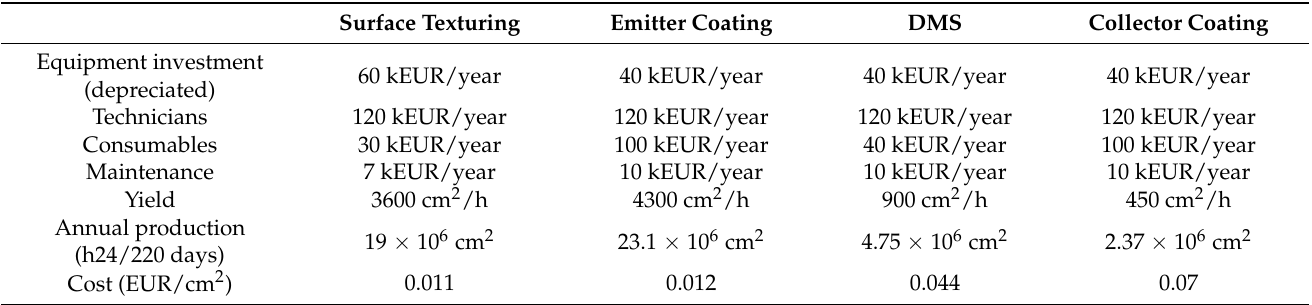
Table A4. Estimation of the cost in EUR/cm 2 for the different technologies involved in the TEC fabri- cation.